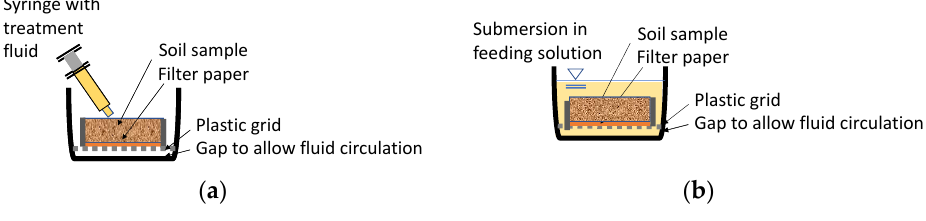
Figure 2. Experimental setup: ( a ) first three days and ( b ) submersion.